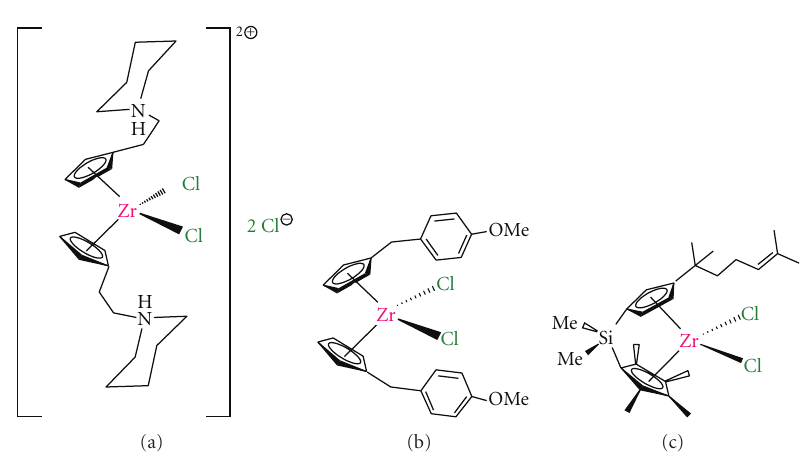
Figure 7: Zirconocene derivatives with anticancer activity: (a) zirconocene derivative with alkylammonium substituents; (b) zirconocene-Y; (c) alkenyl-substituted ansa -zirconocene